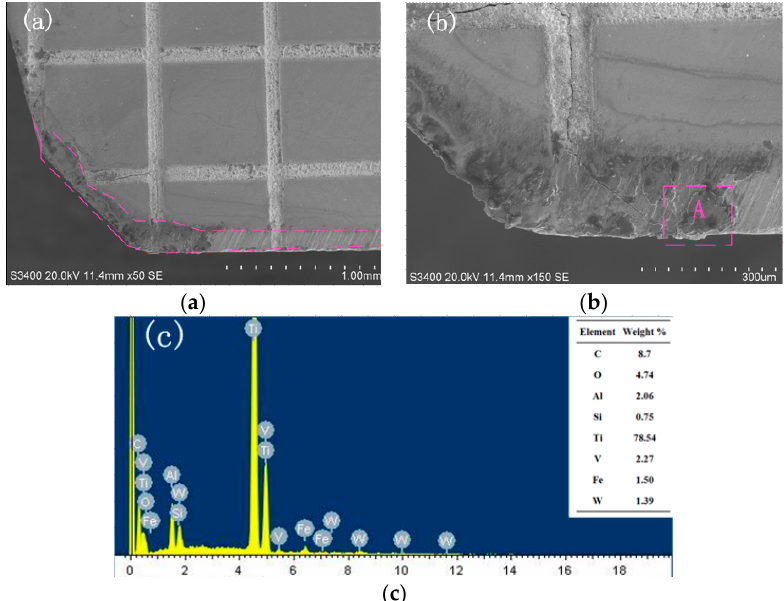
Figure 9. SEM and EDX of wear at the rake face of rhombic textured tool ( v = 90.4 m/min, a p = 0.4 mm). ( a ) Wear morphology; ( b ) Enlarged morphology; ( c ) EDX of zone A.